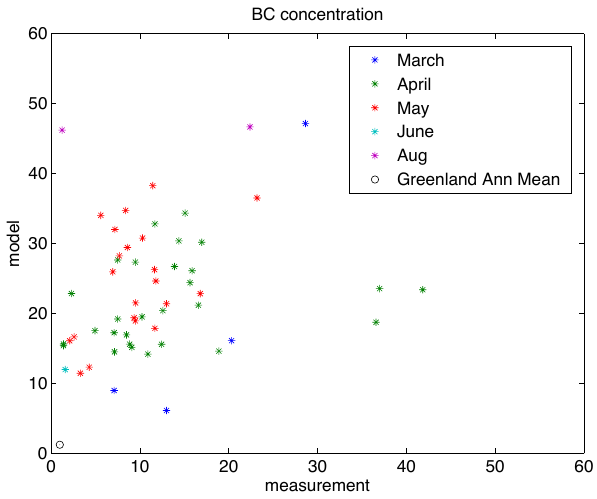
Fig. 4. Model and observed BC concentrations (ngg − 1 ) in the top snow layer on land are compared. Each point represents an average of observations compared with a climatological value for the model grid box that contains those latitude-longitude locations. For com- parison, an annual mean value for the year 2000 from the ice core described in McConnell et al. (2007) is also plotted against model